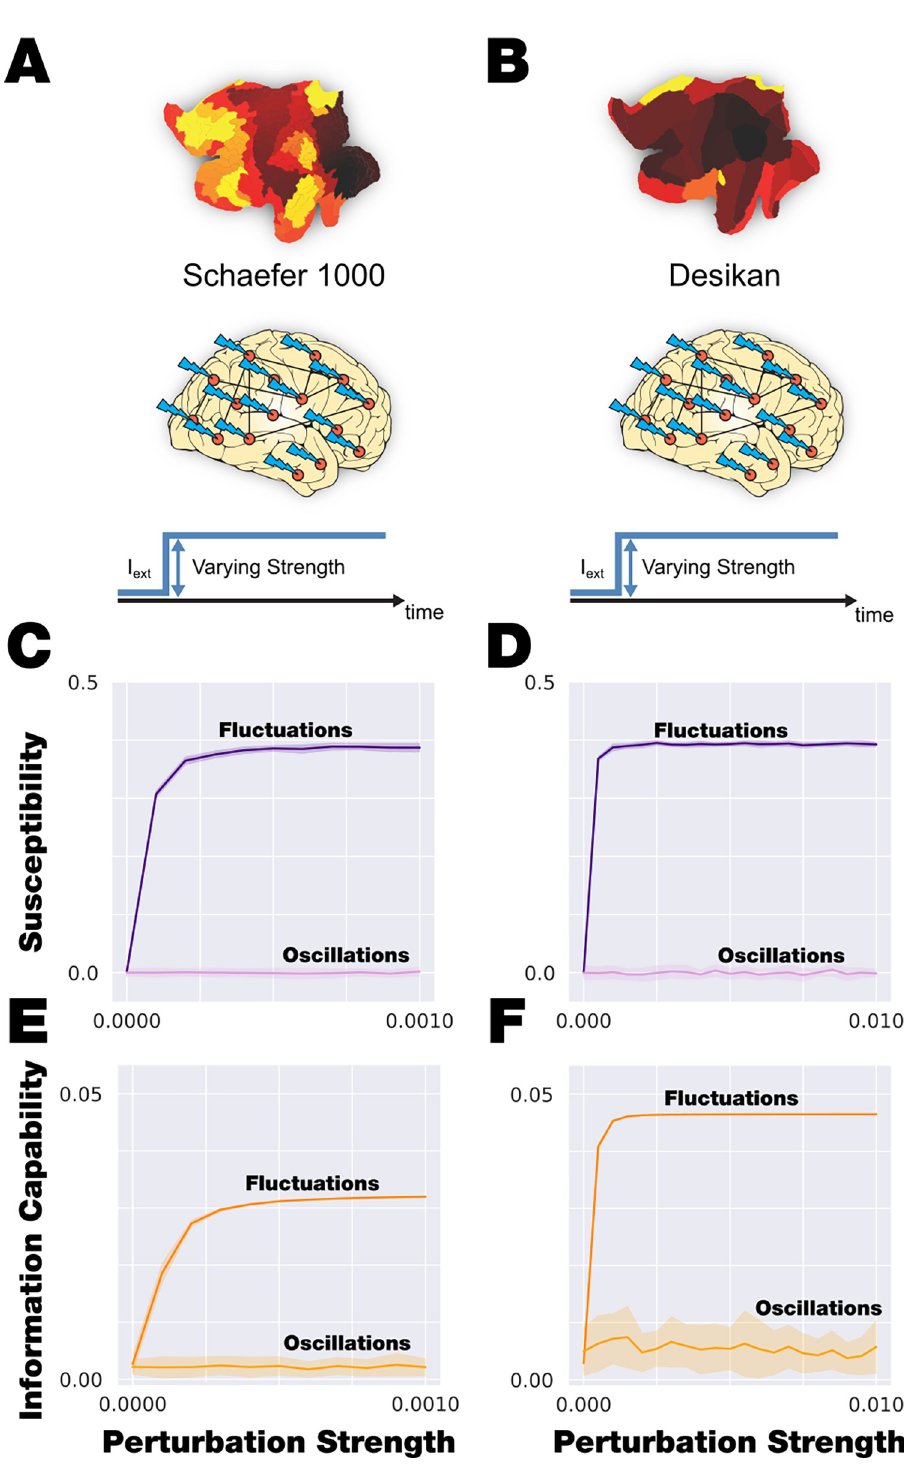
Fig 4. Global and sustained strength-dependent perturbation. A) We applied global strength-dependent, sustained perturbation in Schaefer1000 parcellation, and B) the same perturbation in Desikan-Killiany parcellation. C-D) The evolution of local and global Susceptibility (fine parcellation, panel C and coarse parcellation, panel D, respectively) as a function of perturbation strength. In dark purple is shown the response of the subcritical fluctuating regime, while in light purple, the behaviour of the supercritical oscillating regime. The subcritical regime is clearly more susceptible than the supercritical regime that is almost unaltered by the perturbation. E-F) The evolution of global